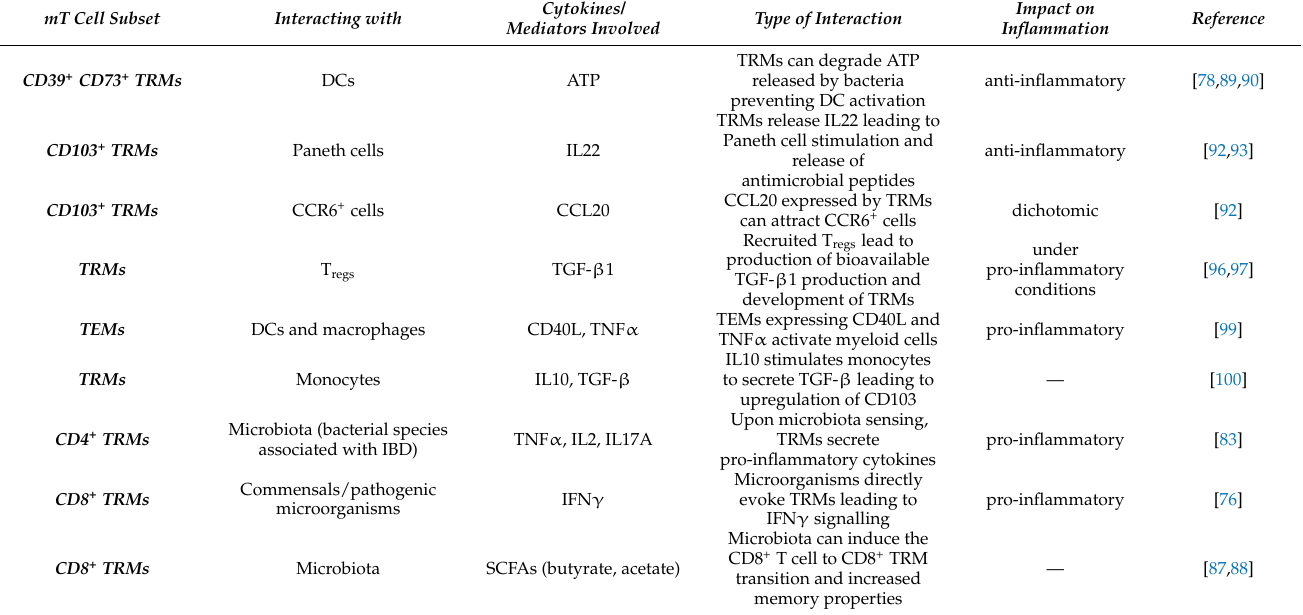
Table 1. Overview of proposed interactions of mT cells with other cell types and the